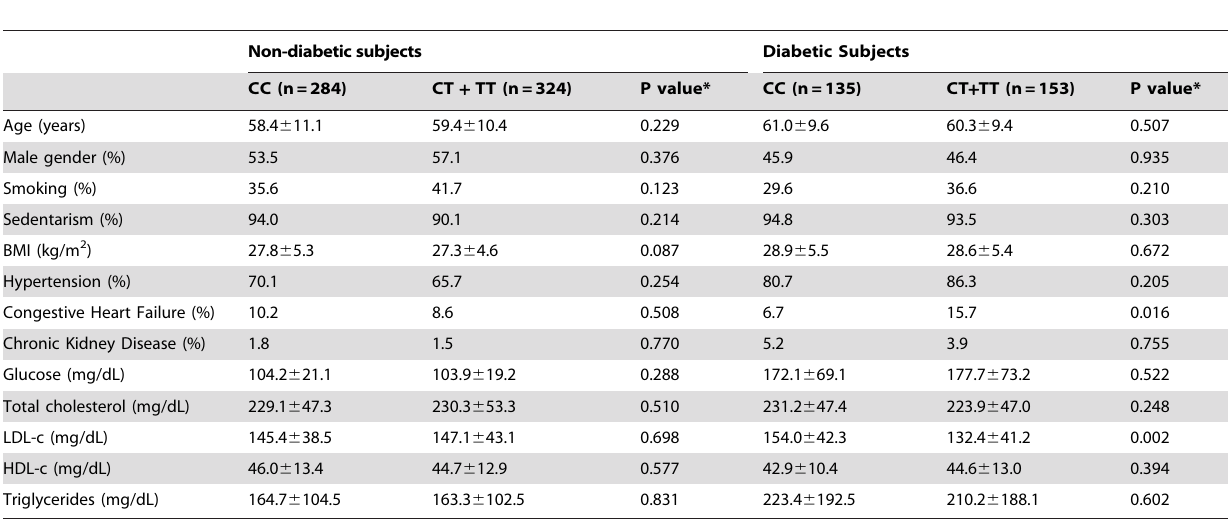
Table 1. Demographic and laboratorial characteristics of non-diabetic and diabetic subjects from the cross-sectional population according to TCF7L2 genotype.